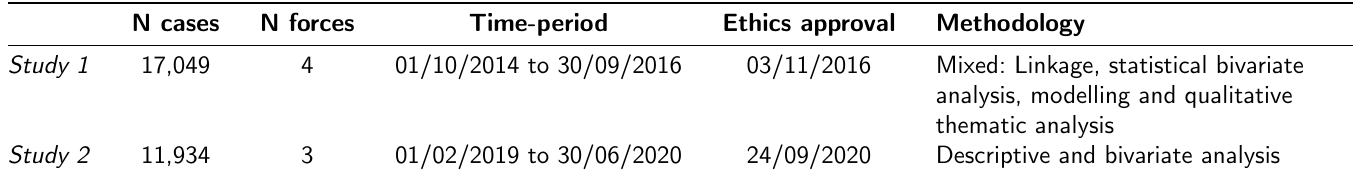
Table 1: Summary of